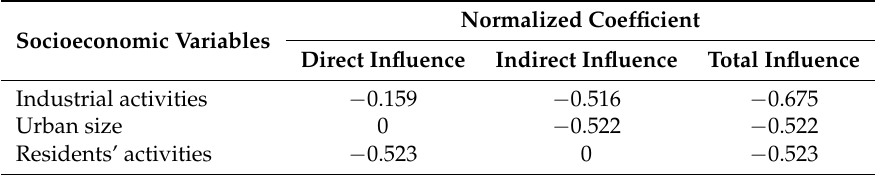
Table 6. The influence of socioeconomic variables on visibility in Xiamen, China 1987–2016. Normalized Coefficient Socioeconomic Variables Direct Influence Indirect Influence Total Influence